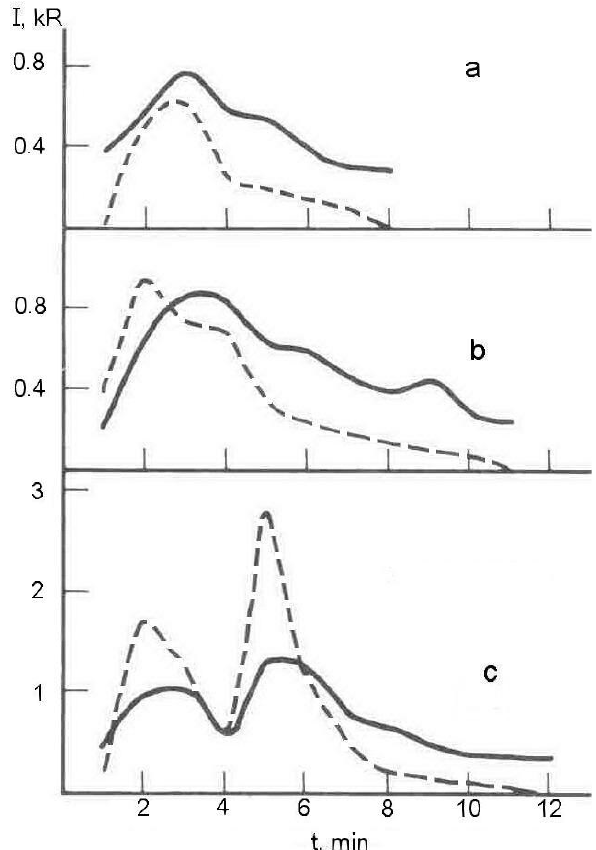
Figure 16. Temporal variations of (OI) 630.0 (heavy lines) and 557.7nm (thin lines) emissions in different types of dayside auroral arcs (Vorobjev et al., 1988a). The three panels stand for various sub- types of rayed arc emissions: (a) near or just prior to noon, (b) just after noon, and (c) brighter afternoon emissions (see text for de-